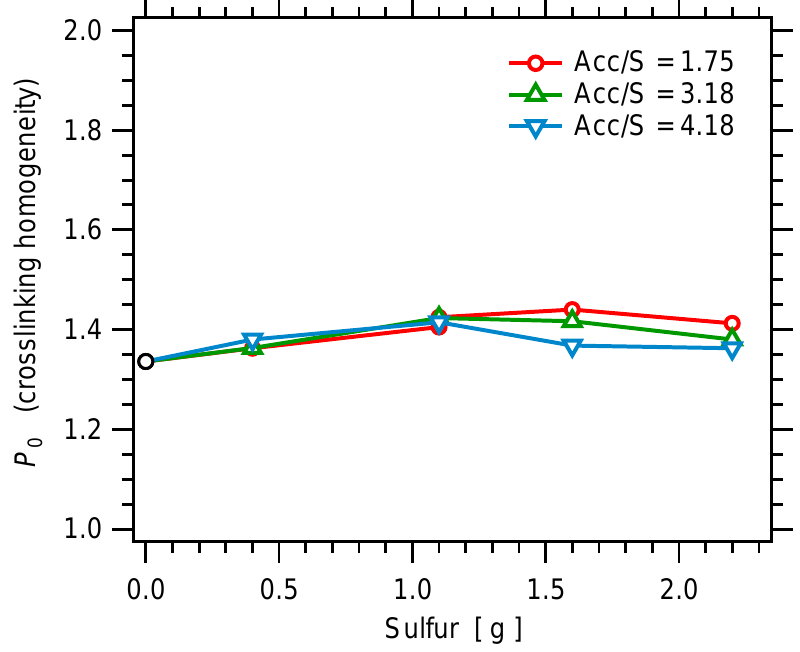
Figure 5. Parameter P 0 , related to the homogeneity of the crosslink density, as a function of the sulfur amount in the series of SBR